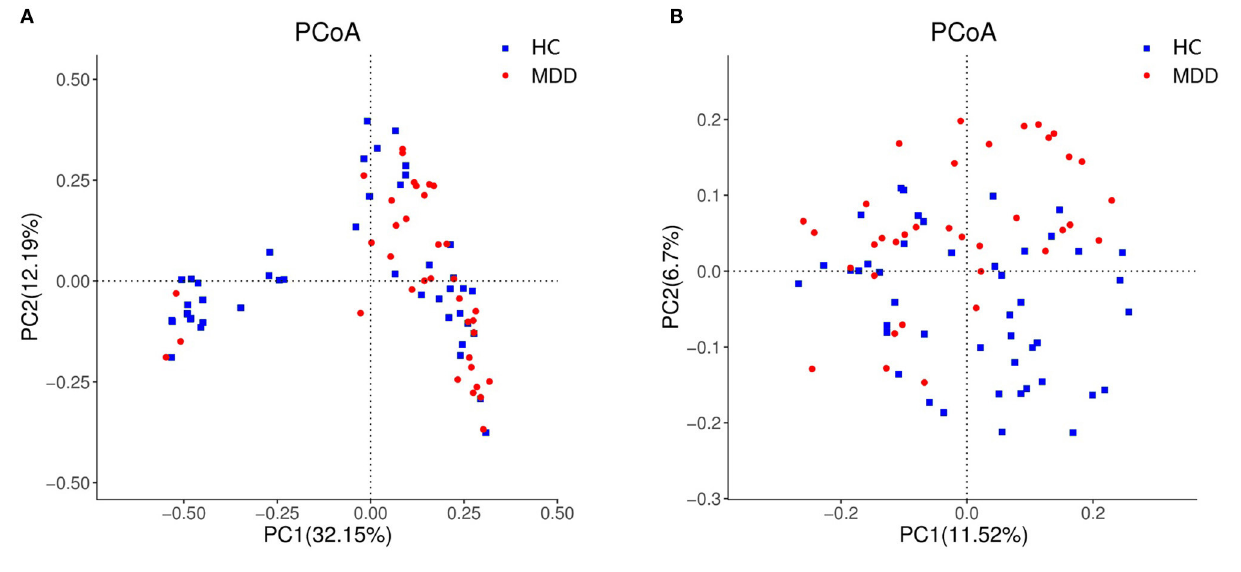
roles on the distribution of microflora in MDD patients, while BMI and age played important roles on HC. Among them, HAM-D has the most significant effect on community variation ( p < 0.05) ( Supplementary Table 5 ). Furthermore, unweighted and weighted ANOSIMs revealed significant differences between the two groups. Beta diversity was measured based on the unweighted ( r = 0.067, p = 0.007) and the weighted ( r = 0.075, p = 0.007) UniFrac distance matrix of the differences between groups, as shown in Figure 3 , suggesting dissimilar microbiota